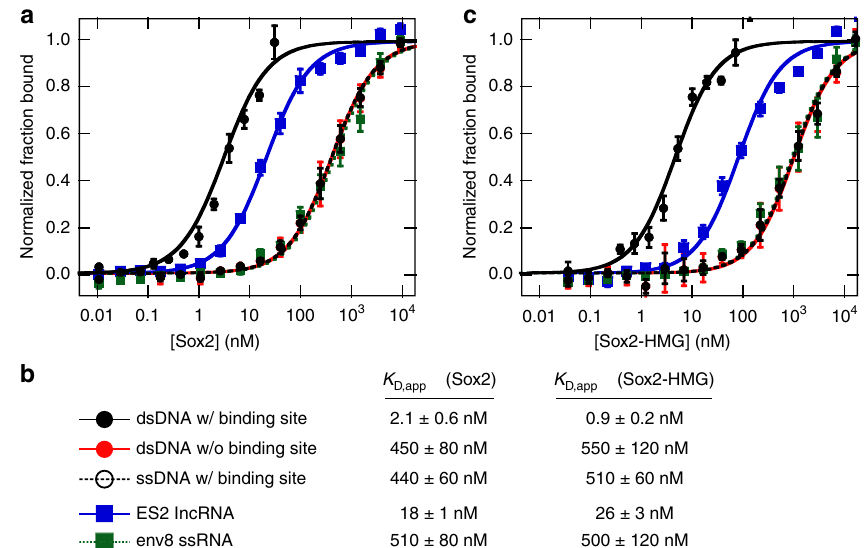
Fig. 1 Nucleic acid binding by Sox2 and Sox2-HMG. a Average binding curves of full-length Sox2 to nucleic acid ligands. Curves are presented as the average of normalized fraction bound with error bars displaying the standard deviation. b Figure legend and measured binding af fi nity values for panels ( a ) and ( c ). Values are presented as the average and s.e.m. of n = 4 technical replicates with the exception of Sox2-HMG/ ES2 which is the average and s.e.m. of n = 10 technical replicates. c Representative binding curves of the Sox2-HMG domain to nucleic acid ligands. Curves and error bars displayed as in panel ( a